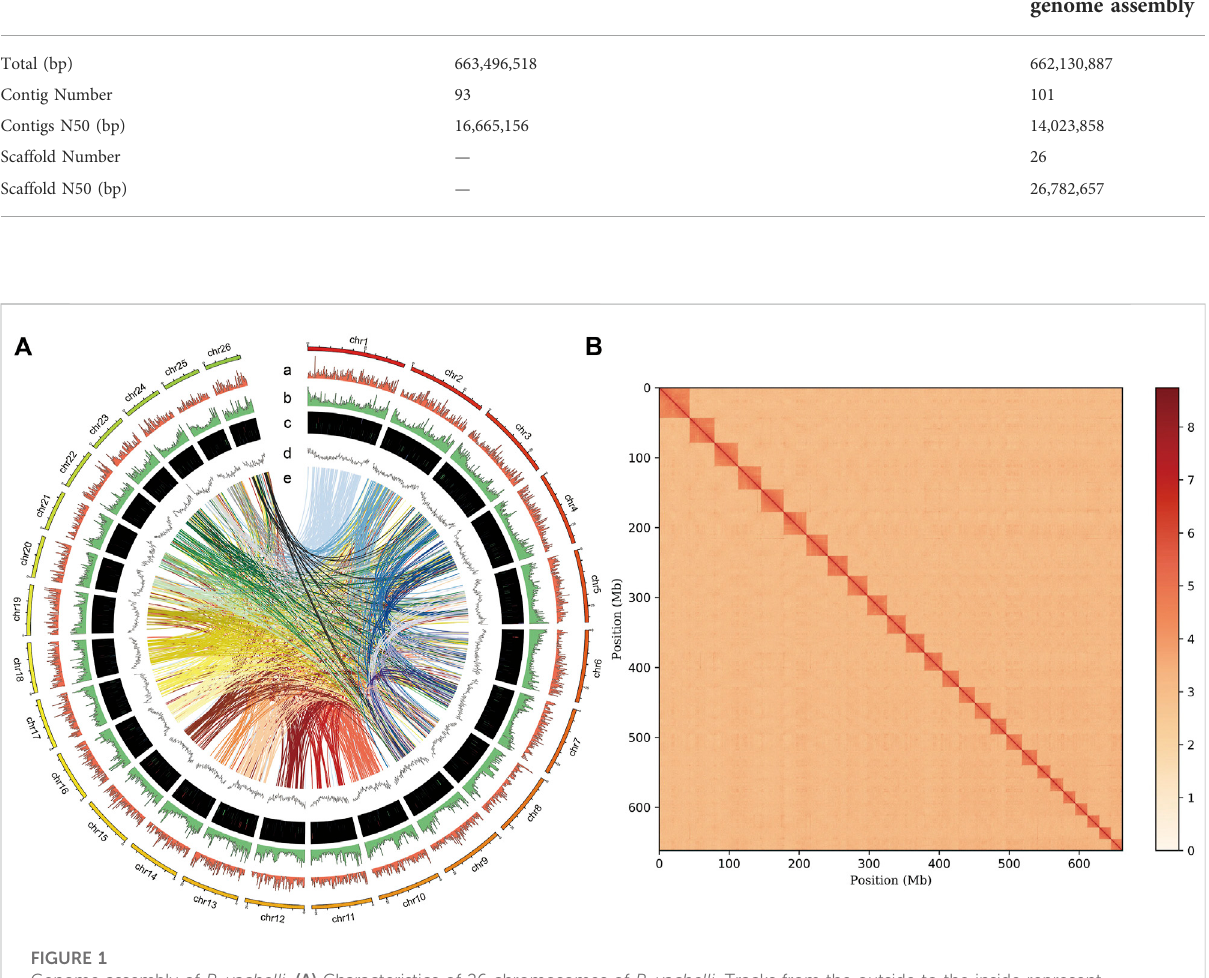
675.72 Mb, a heterozygosity rate of 0.45%, and repeat ratio of 43.31%. Thereafter, ~158 Gb subreads data were produced for